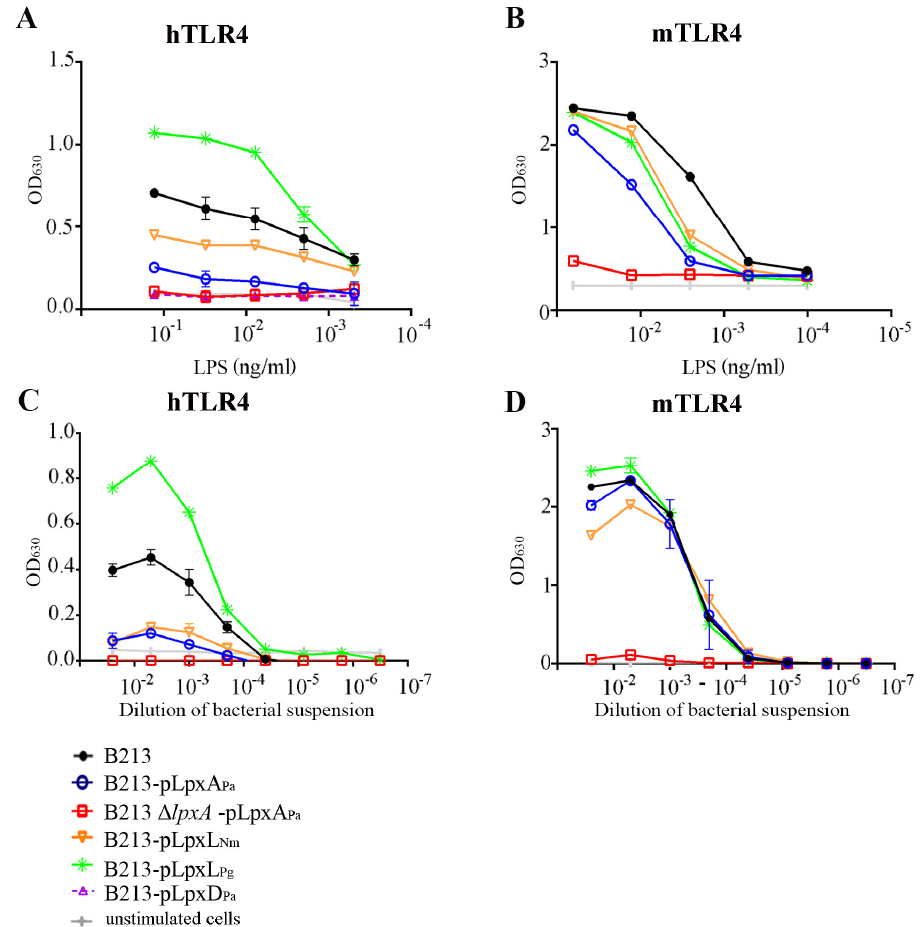
Figure 3. Stimulation of HEK293-Blue cells expressing hTLR4 ( A , C ) or mTLR4 ( B , D ) with purified LPS ( A , B ) or whole-cell preparations of B213 and derivatives ( C , D ). LPS preparations and bacterial suspensions were serially diluted. After incubation for 2 h with HEK293-Blue cells expressing mTLR4 or for 4 h with HEK293-Blue cells expressing hTLR4, alkaline phosphatase activity was determined. Graphs show the mean and standard deviation from a representative experiment of three repeats in duplicate.